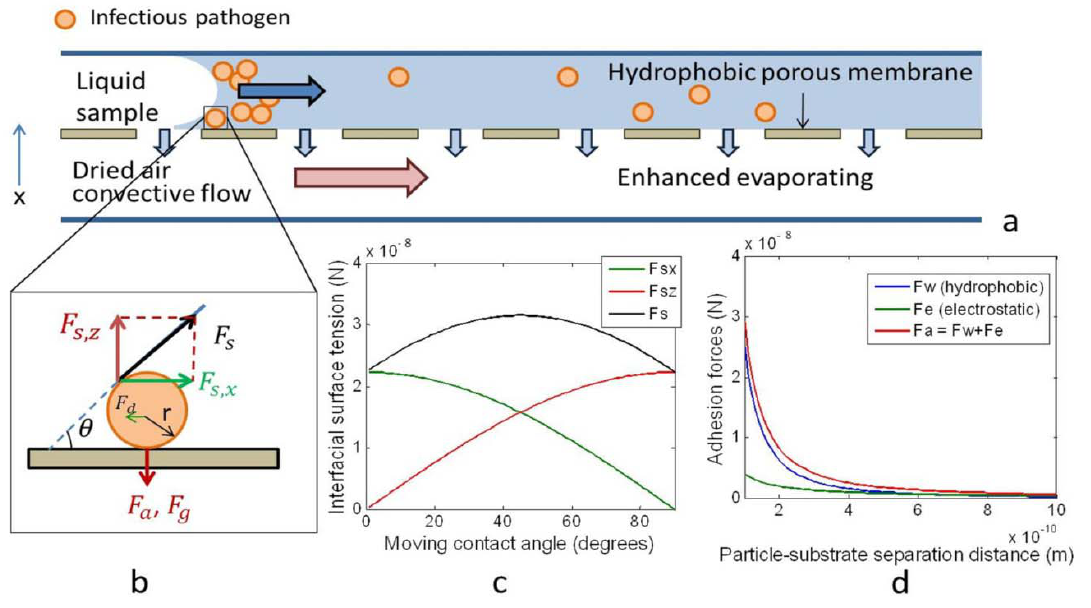
Figure 1. The evaporation microfluidics utilize a mass exchange process driven by the partial pressure gradient of the water vapor across a hydrophobic porous membrane to concentrate particles along the moving fluid meniscus. ( a ) Schematic of the convective evaporation microfluidic device. As convective air flows in the lower layer, liquid sample on the upper layer evaporates through the pores. ( b ) Free body diagram of a single viral particle in the fluid meniscus. These forces include the interfacial surface tension ( F ), s adhesion force ( F ), which is proportional to the sum of van der Waal’s and electrostatic a ), gravitational force ( F ), and buoyancy forces (not shown). forces, Stokes drag force ( F d g ( c ) The interfacial surface tension is decomposed in the horizontal ( F ) and vertical ( F ) sx sz directions. As the moving contact angle increases, F decreases, while F increases. ( d ) The sx sz ) decreases as their separation adhesion force between the particle and the substrate ( F a distance increases.